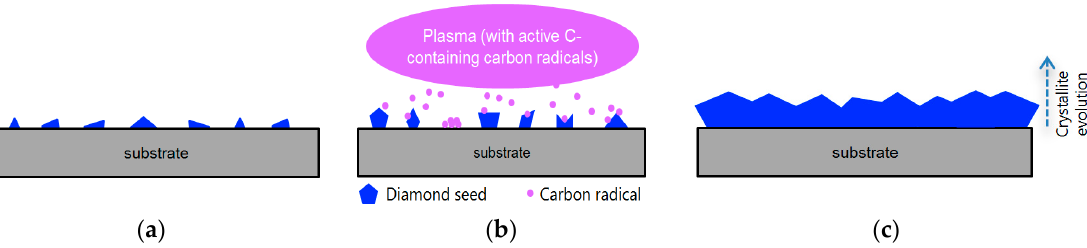
Figure 1. Schematic representation of the various steps of chemical vapour deposition (CVD) diamond growth on non-diamond substrates: ( a ) substrate surface enriched with diamond seeds, ( b ) seeded substrate exposed to diamond growth conditions, and ( c ) coalesced diamond film.